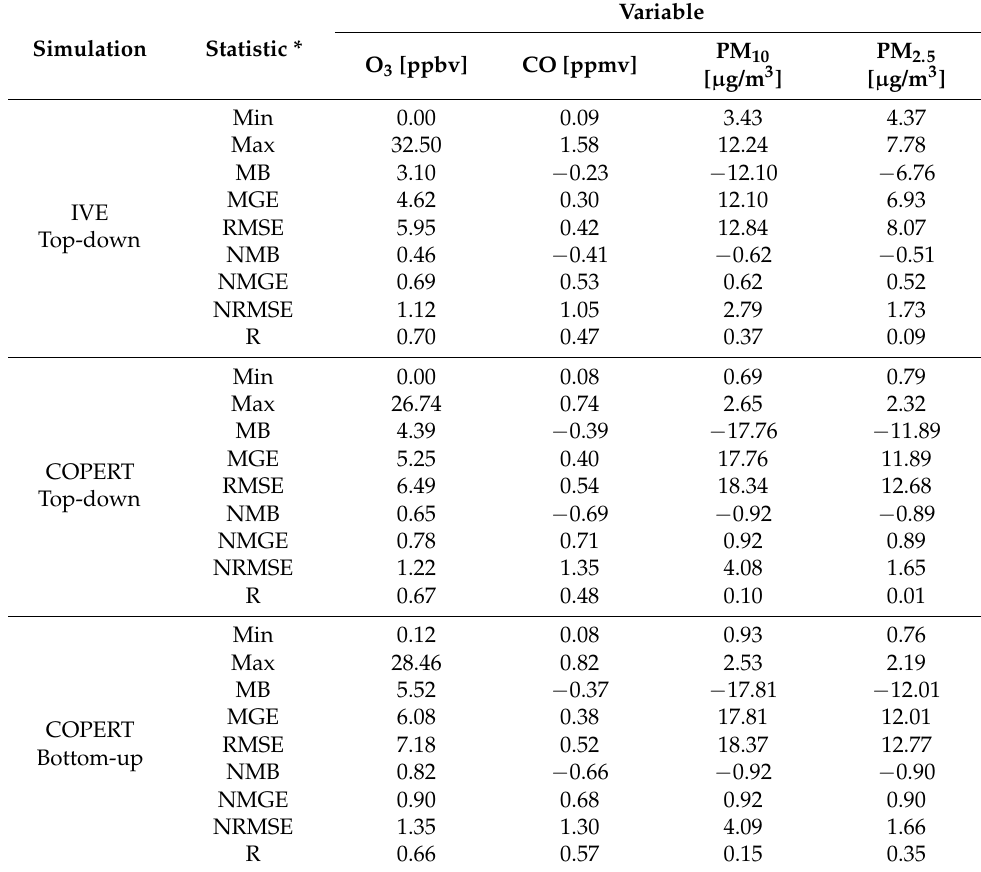
Table 5. Performance